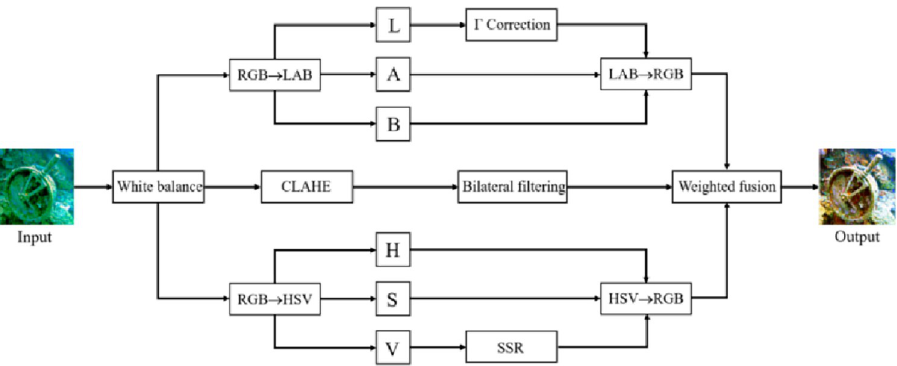
Fig 3. The flowchart of the proposed underwater image enhancement